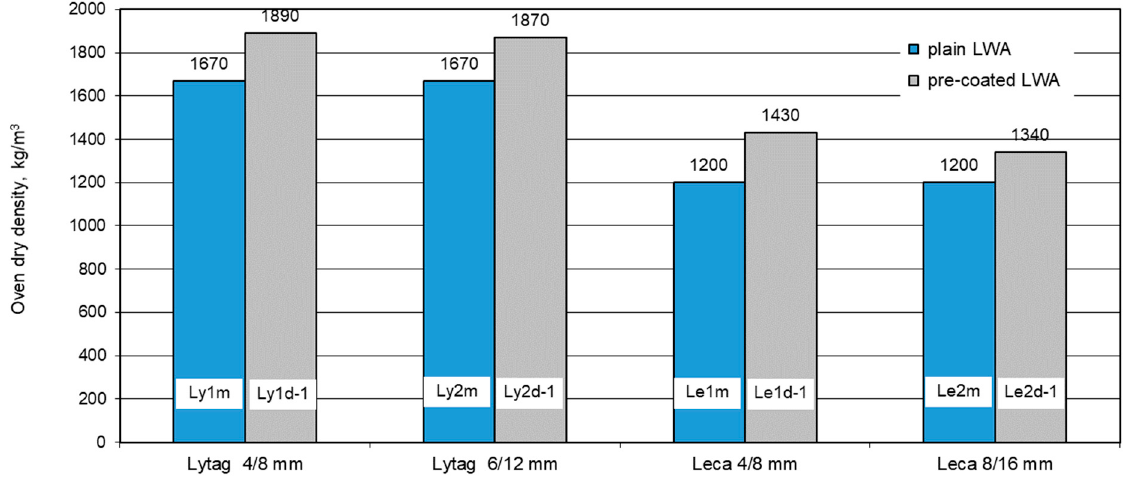
Figure 11. Mean oven dry density of concretes with plain and pre-coated lightweight aggregates.